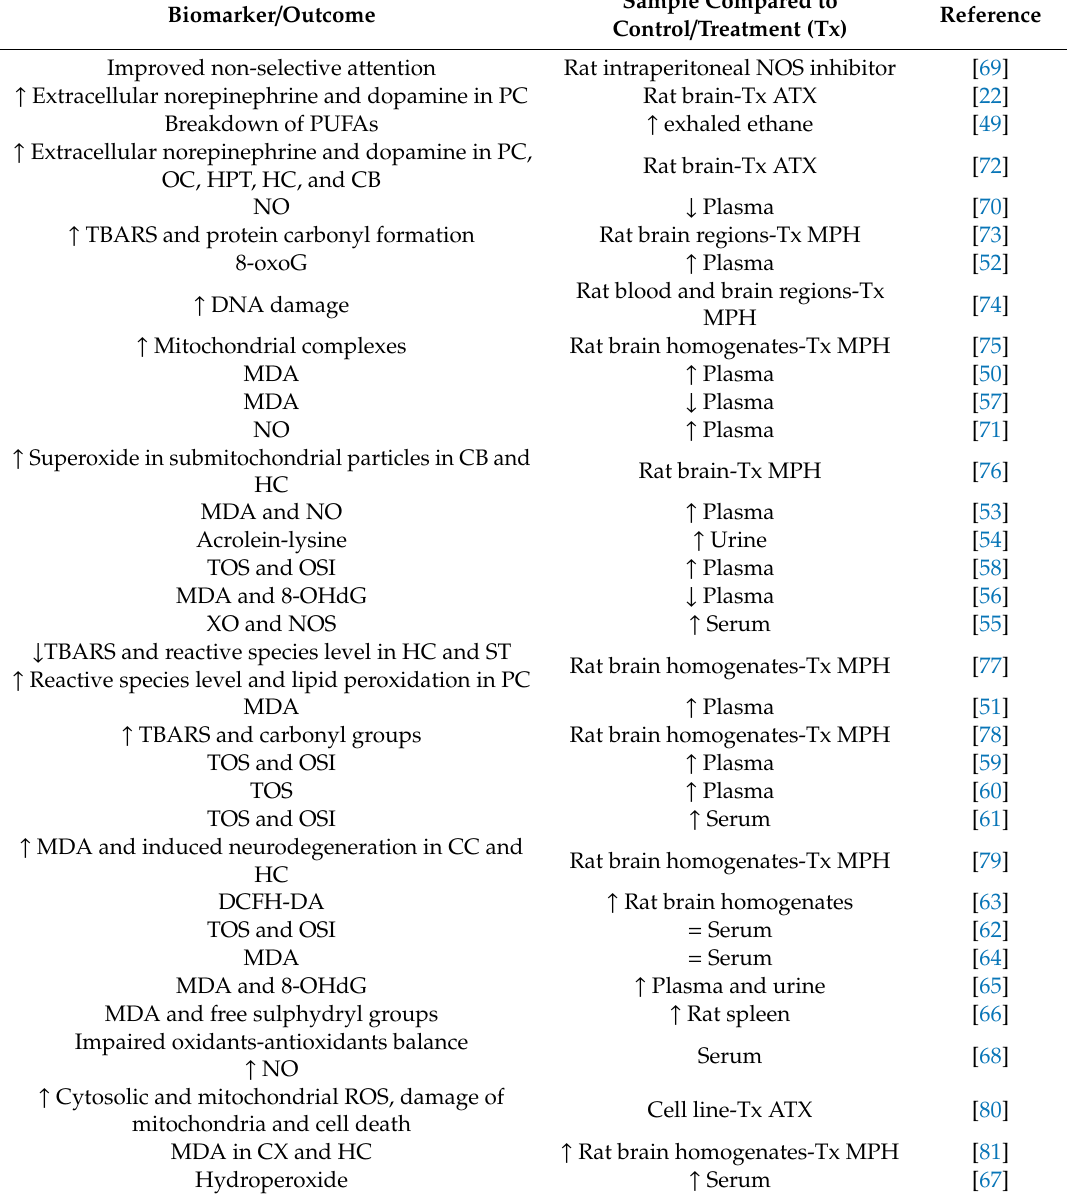
Table 1. Summary of oxidative and nitrosative stress biomarkers and